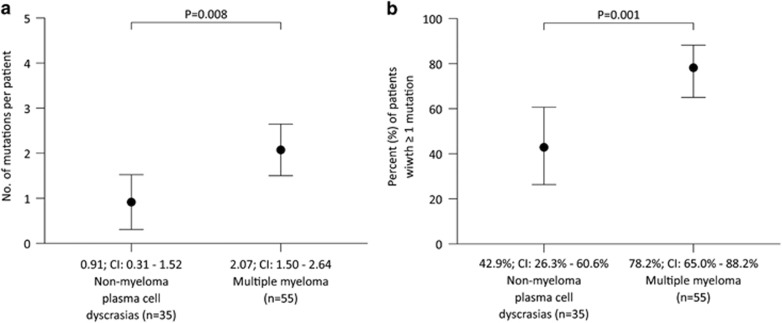
Differences in the mutational load between disease categories. (a) Difference in mutational frequency (number of mutant exons per patient) between myeloma and non-myeloma plasma cell dyscrasias. (b) Difference in percentage of patients with mutations (⩾1 mutation per case) between myeloma and non-myeloma plasma cell dyscrasias.